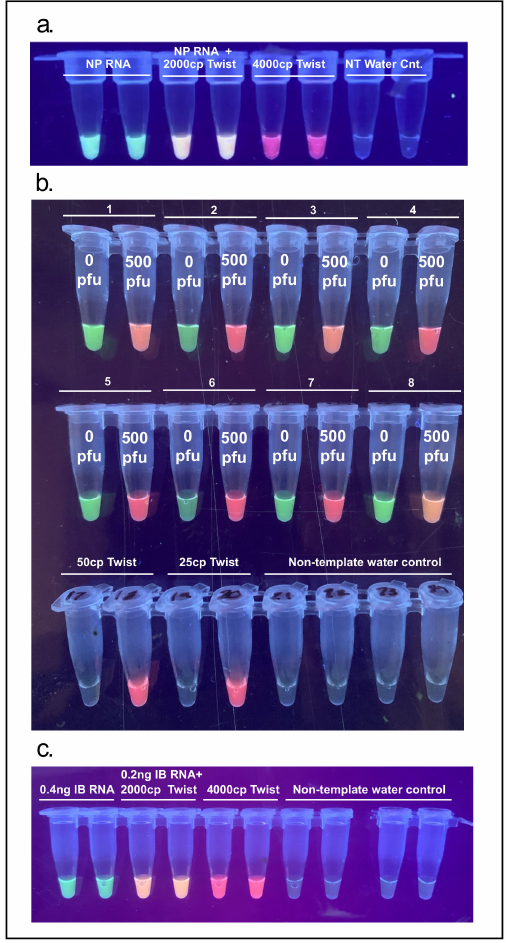
Figure 8. Multiplexed reactions allow for the detection of different viral targets or internal controls: ( a ) green fluorescence indicates BPIFA1 amplification, red fluorescence indicates Twist Bioscience SARS-CoV-2 control amplification, and orange fluorescence indicates both BPIFA1 and Twist Bio- science SARS-CoV-2 control amplification, (NP—nasopharynx); ( b ) multiplexed reactions for BPIFA1 and SARS-CoV-2, 11 Nasal pharynx flush thru (NFT) samples and also spiked with 500 PFU of SARS- CoV-2 and extracted with TRIzol chloroform method, 50 cp Twist synthetic controls, 25 cp Twist synthetic controls and non-template water controls; ( c ) green fluorescence indicates influenza B (IB) RNA amplification, red fluorescence indicates SARS-CoV-2 amplification, and orange fluorescence indicates both influenza B and SARS-CoV-2